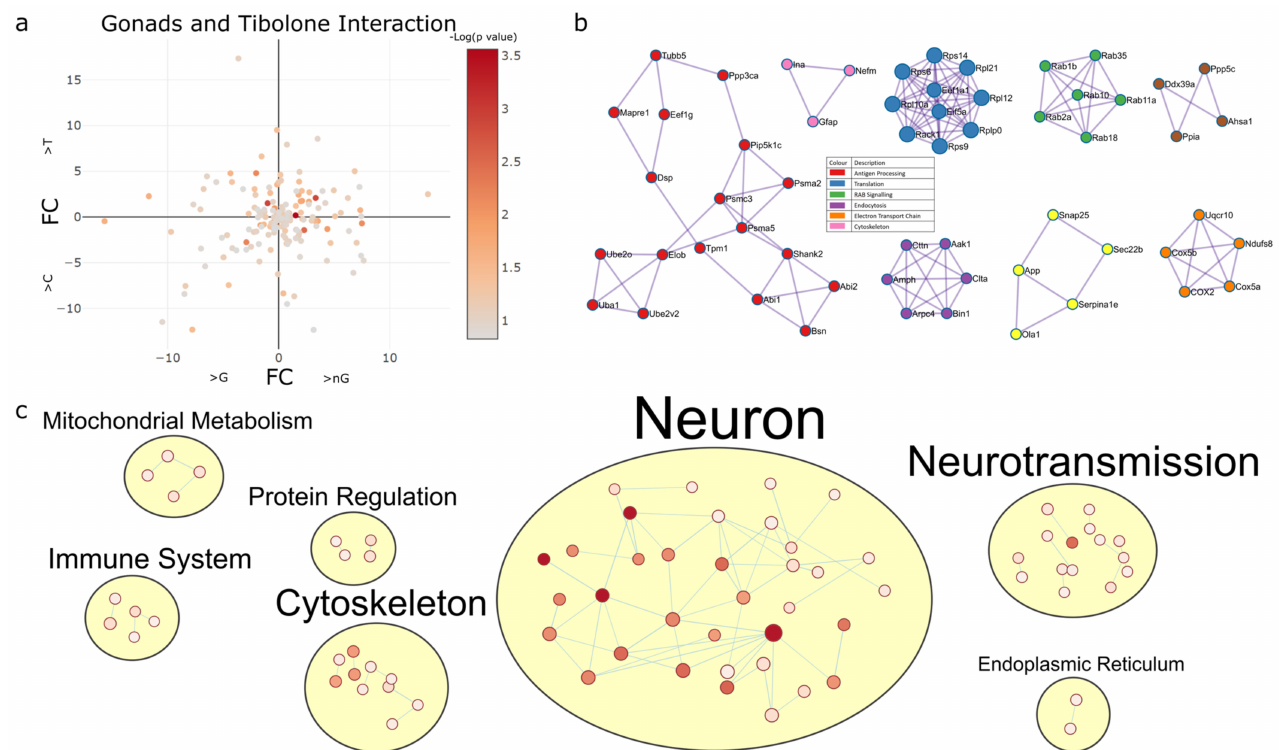
Figure 6. Gonadectomy alters protein expression related to RAB geranylgeranylation, ribosomes and ATP synthesis following Tibolone treatment. ( a ) A total of 163 proteins were found to be regulated by gonad–Tibolone interactions. ( b ) PPI analysis of proteins regulated by gonad–Tibolone interactions found that RAB geranylgeranylation (green, p = 3.16 × 10 − 16 ), ribosomes (blue, p = 3.16 × 10 − 13 ), ATP synthesis-coupled electron transport (orange, p = 3.16 × 10 − 13 ), clathrin-mediated endocyto- sis (purple, p = 6.3 × 10 − 11 ), antigen processing, ubiquitination and proteasome degradation (red, p = 2.5 × 10 − 9 ) and intermediate filament cytoskeleton organization (pink, p = 1.58x10 − 8 ) were ing, the regulation of protein polymerisation was most significantly enriched ( p = 1.25 × 10 − 8 ). ( c ) When enriched functions regulated by gonad–Tibolone interactions were mapped into